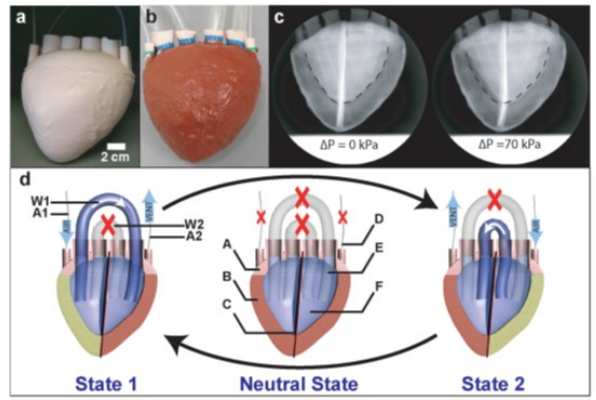
Figure 1: Fabricated a functional fluid pump with a biologically inspired external